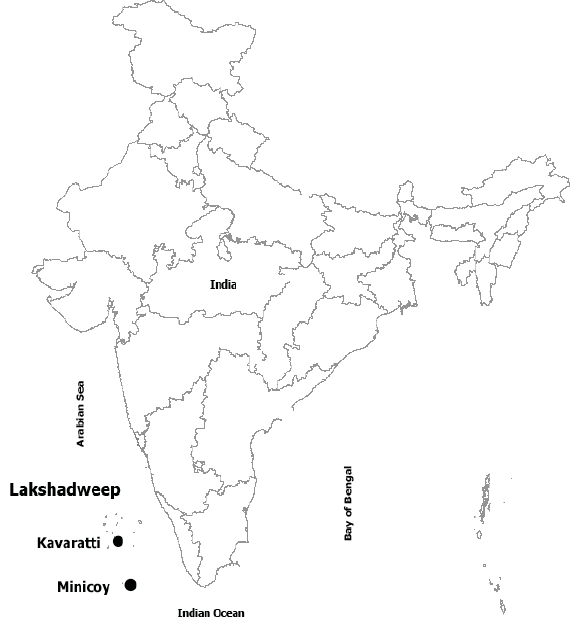
Figure 1. Survey locations in the Lakshadweep (map not up to the